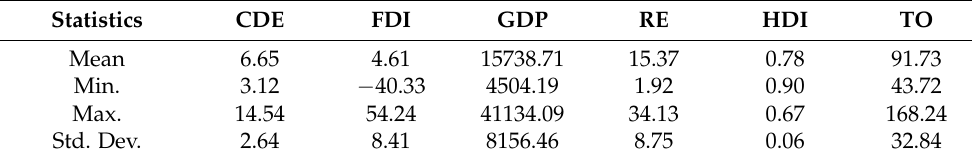
Table 2. Summary Statistics of Dependent and Explanatory Variables.